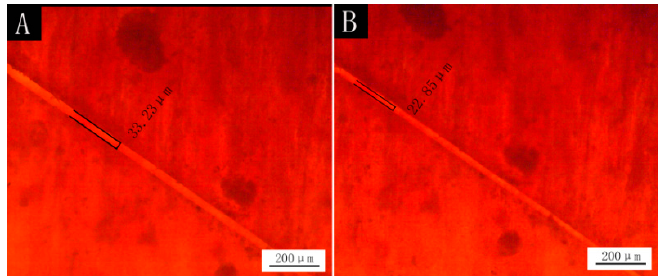
Figure 5. Self-healing test of water-based topcoat paint film (0.67:1 microcapsules): ( A ) for one day, ( B ) for five days.